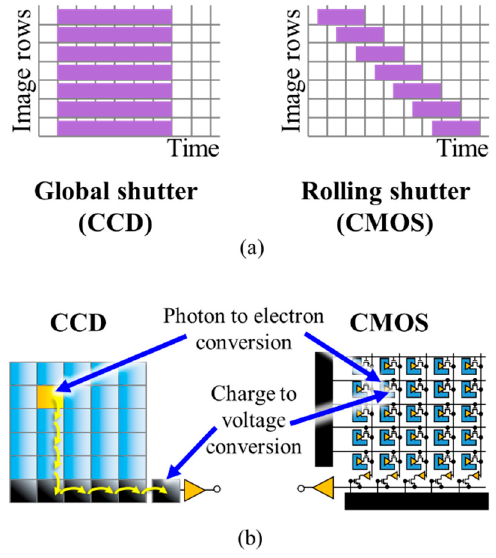
Figure 8. ( a ) A comparison between the GS and RS; ( b ) a structural comparison between CCD and CMOS sensors.